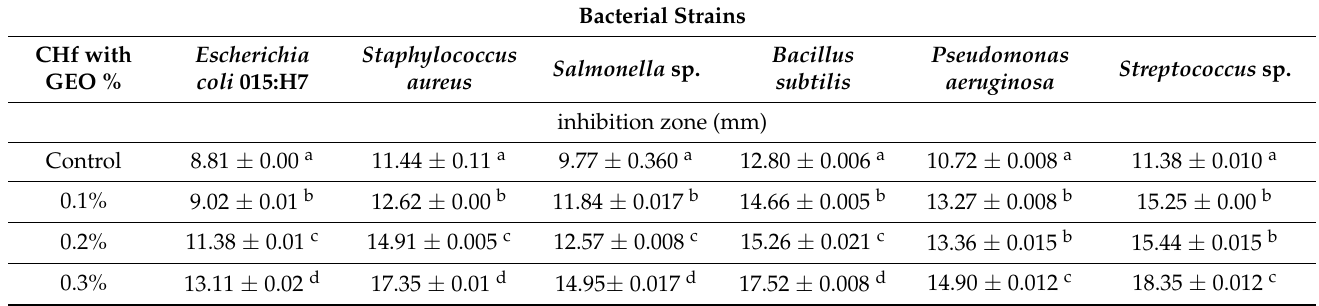
Table 4. Antimicrobial activity of bioactive films with GEO. Note: Different small letters indicate significant differences ( p ≤